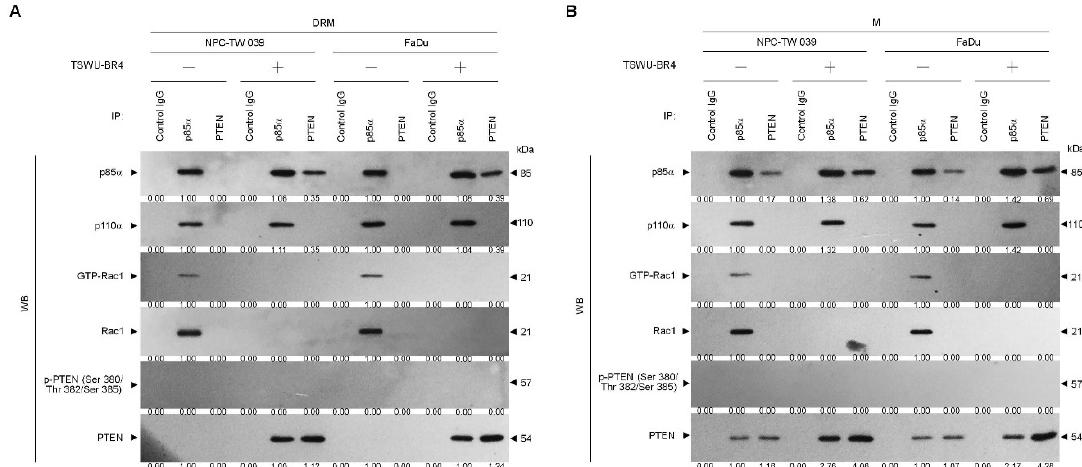
Figure 3. TSWU-BR4 induces p85 α –unphosphorylated PTEN complex formation ( A , B ) Coimmunoprecipitation of p85 α , p110 α , Rac1, and PTEN was performed using the DRM and M fractions prepared from the cells treated as described above. The antibody used for coimmunoprecipitation is indicated at the top. The proteins from the immunoprecipitated complexes were detected using Western blotting with specific antibodies. Normal IgG was used as a control for antibody specificity.